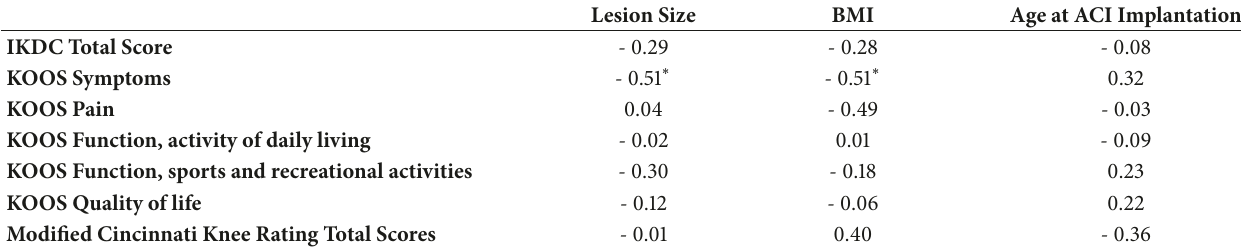
Table 4: Correlation coefficient analysis of the patients’ outcome scores, lesion size, BMI, and age at ACI implantation.